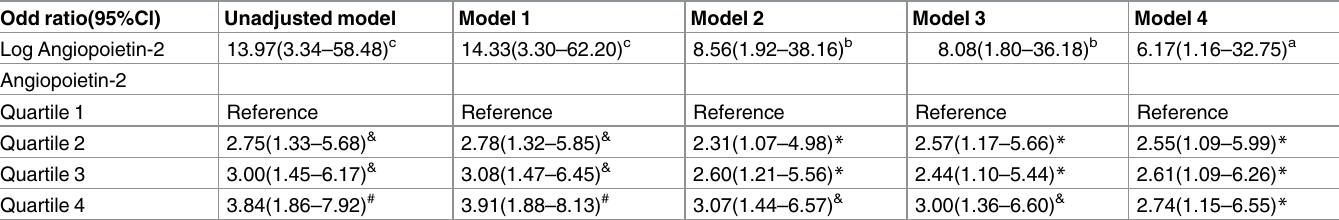
Table 2. The association of circulating angiopoietin-2 with fluid overload (OH > 1.1L). Odd ratio(95%Cl)